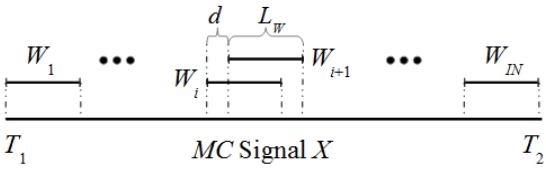
Figure 1. Different windows along the MC signal X .